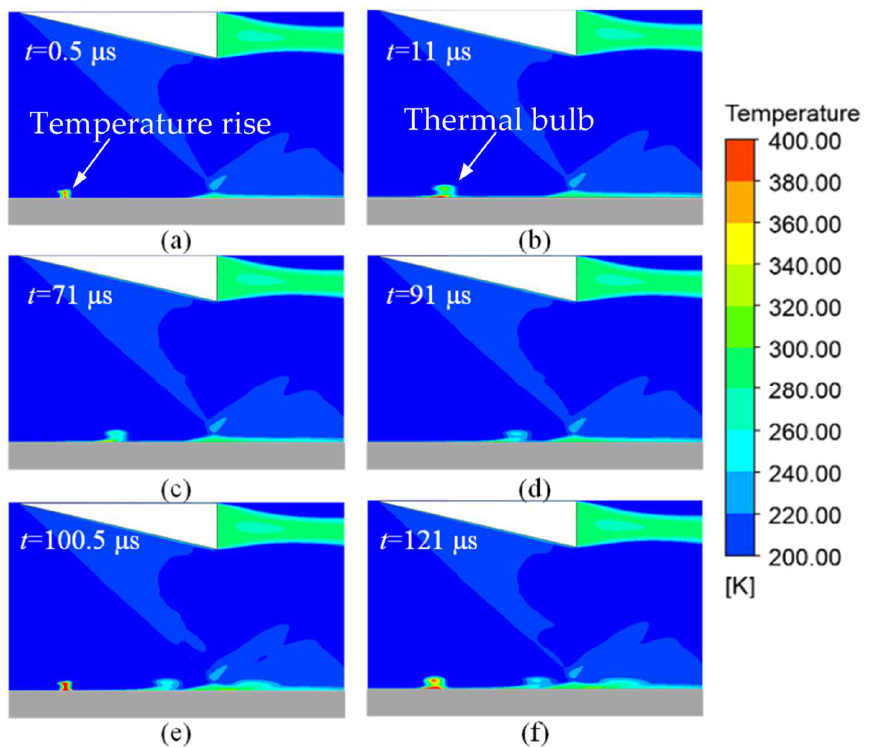
Figure 15. Temperature contour at z = 0 cross section at different moments.